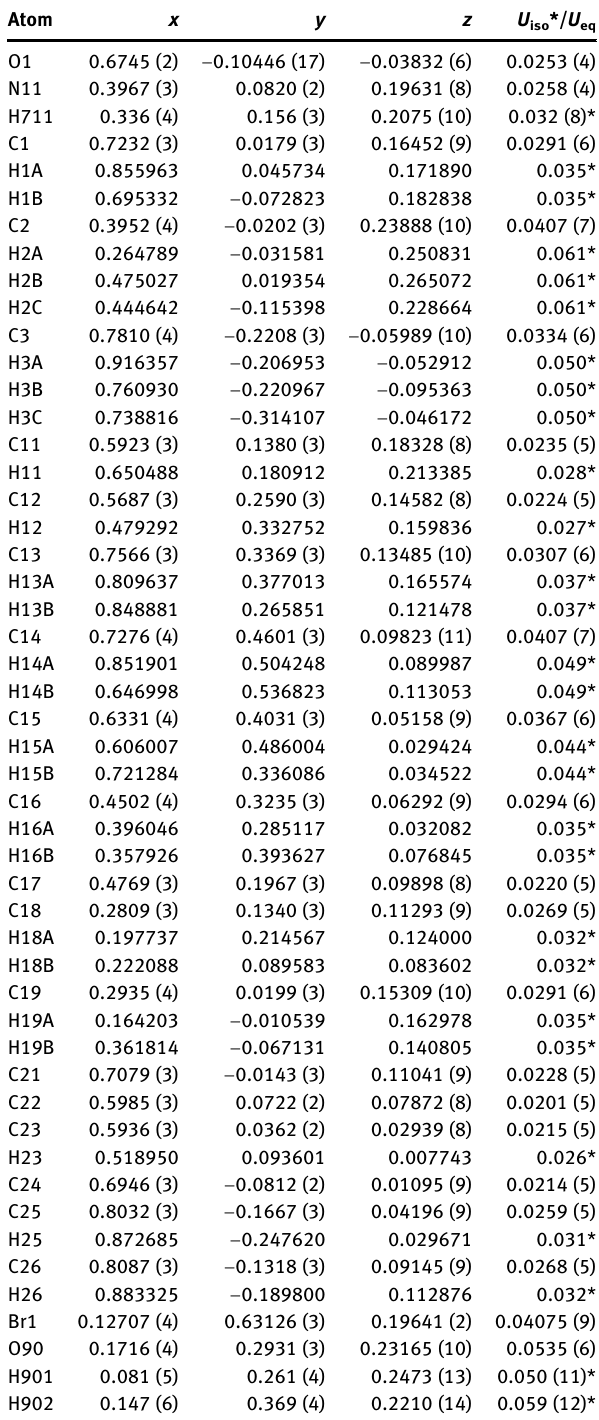
Table  : Fractional atomic coordinates and isotropic or equivalent isotropic displacement parameters (Å 